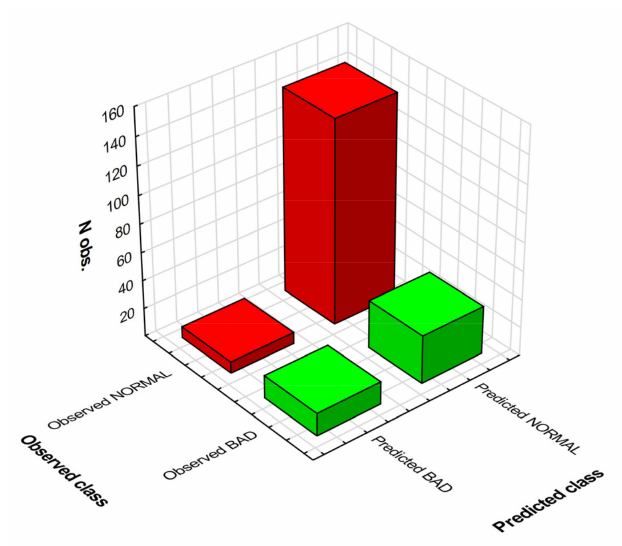
Figure 13. Classification matrix for the classification tree (3Q).